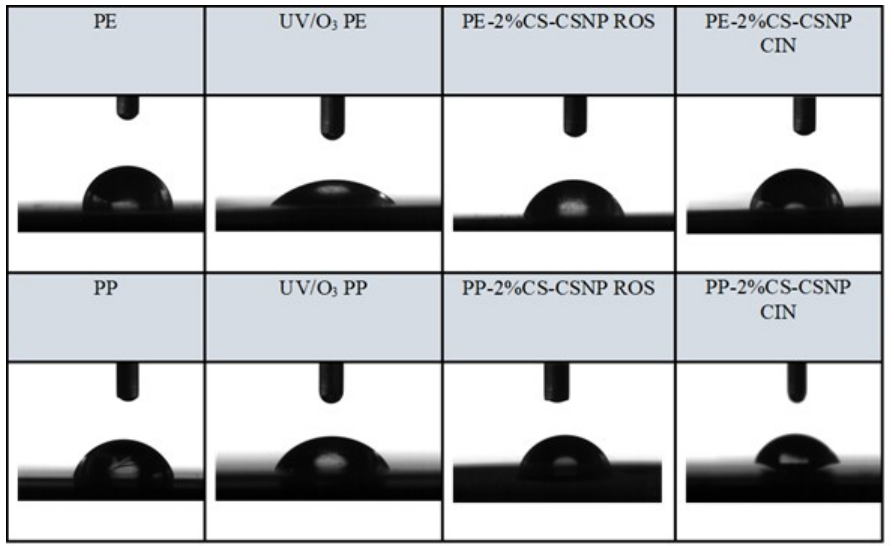
Figure 3. Contact angle (SCA) of foils functionalized by thyme extract (THY) in combination with chitosan.